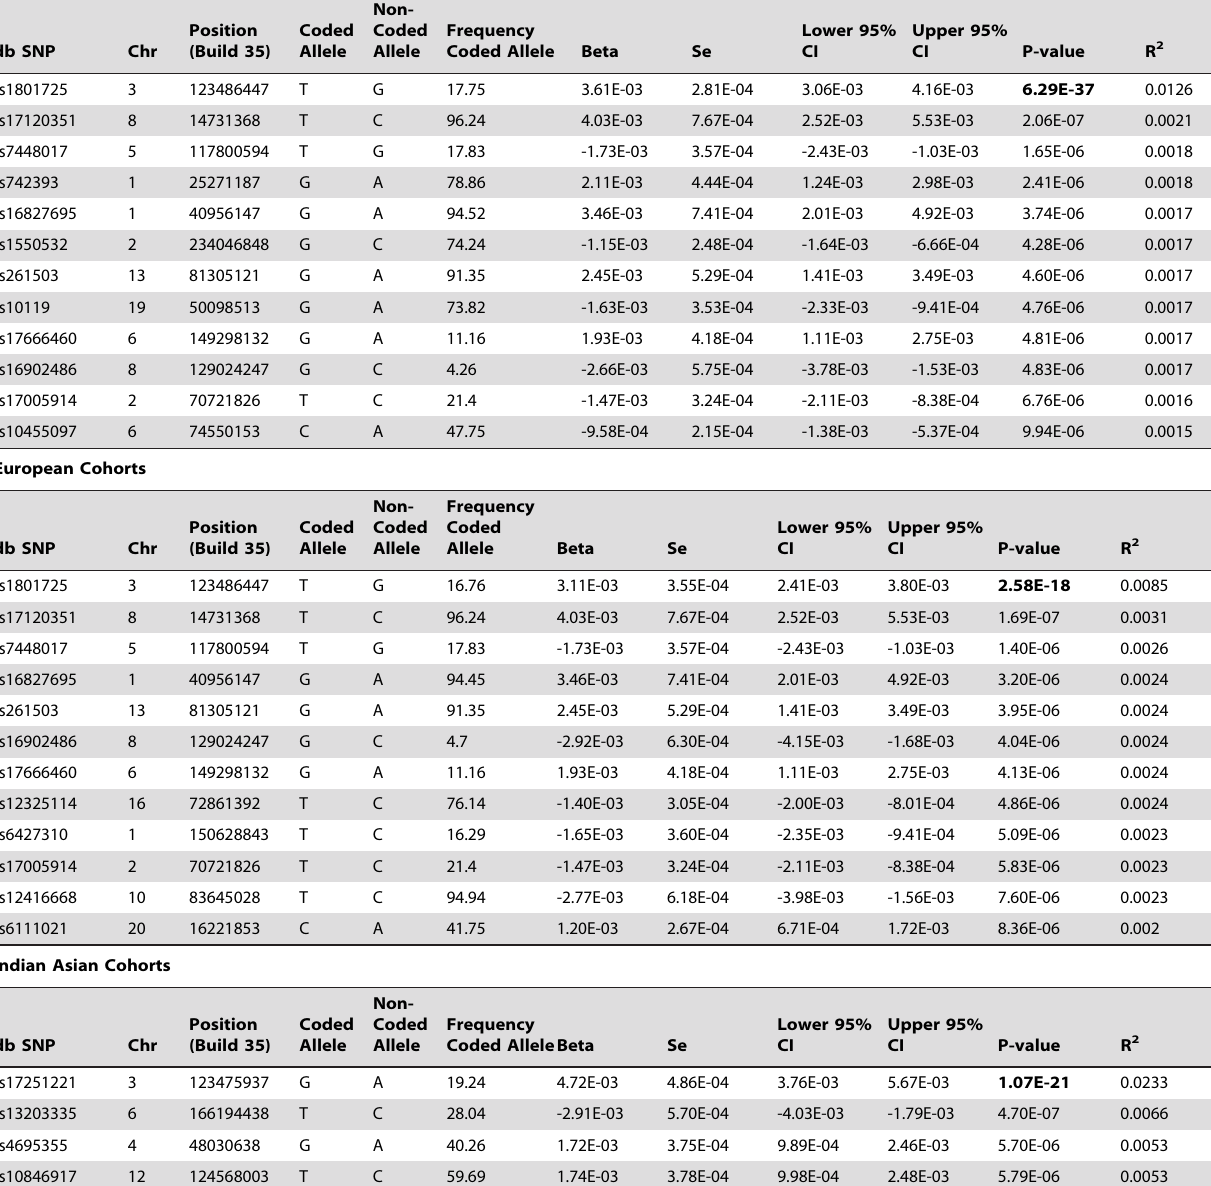
Figure S1 Quantile-Quantile plots of genome-wide association results. Observed -log 10 p-values on the y-axis are plotted against theoretical -log 10 p-values on the x-axis resulting from each meta- analysis. Results are color-coded by chromosome. The top results largely derive from the CASR locus on chromosome 3. Results are shown separately for (A) all cohorts, (B) European cohorts and (C) Indian Asian cohorts.